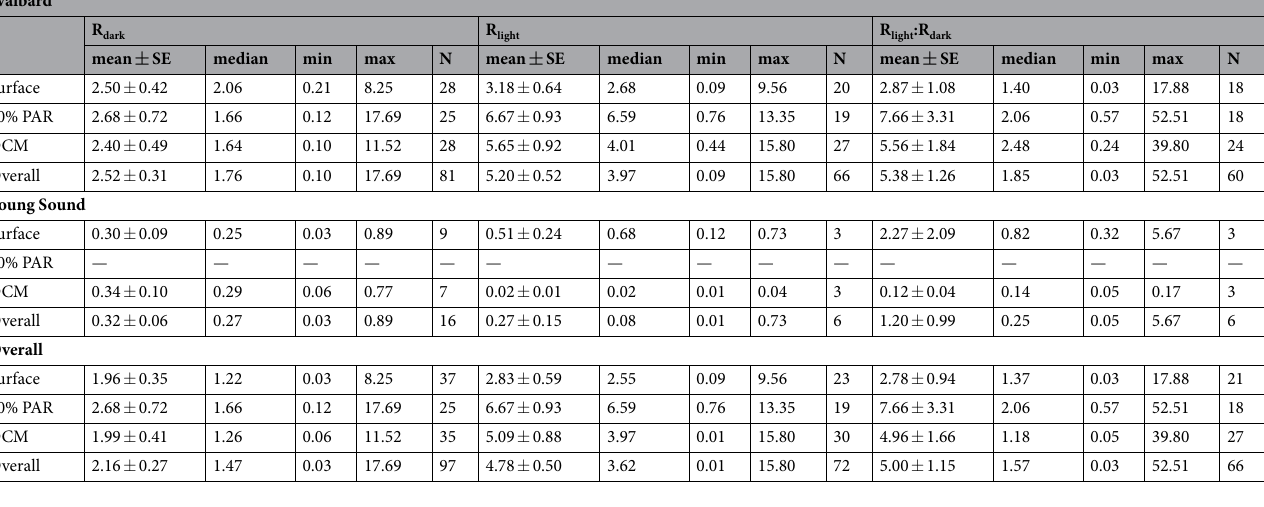
Table 1. Mean ± standard error (SE), median, range and number of estimates (N) for volumetric ( µ mol O 2 L − 1 d − 1 ) rates (respiration in the dark and in the light), and for the ratio between